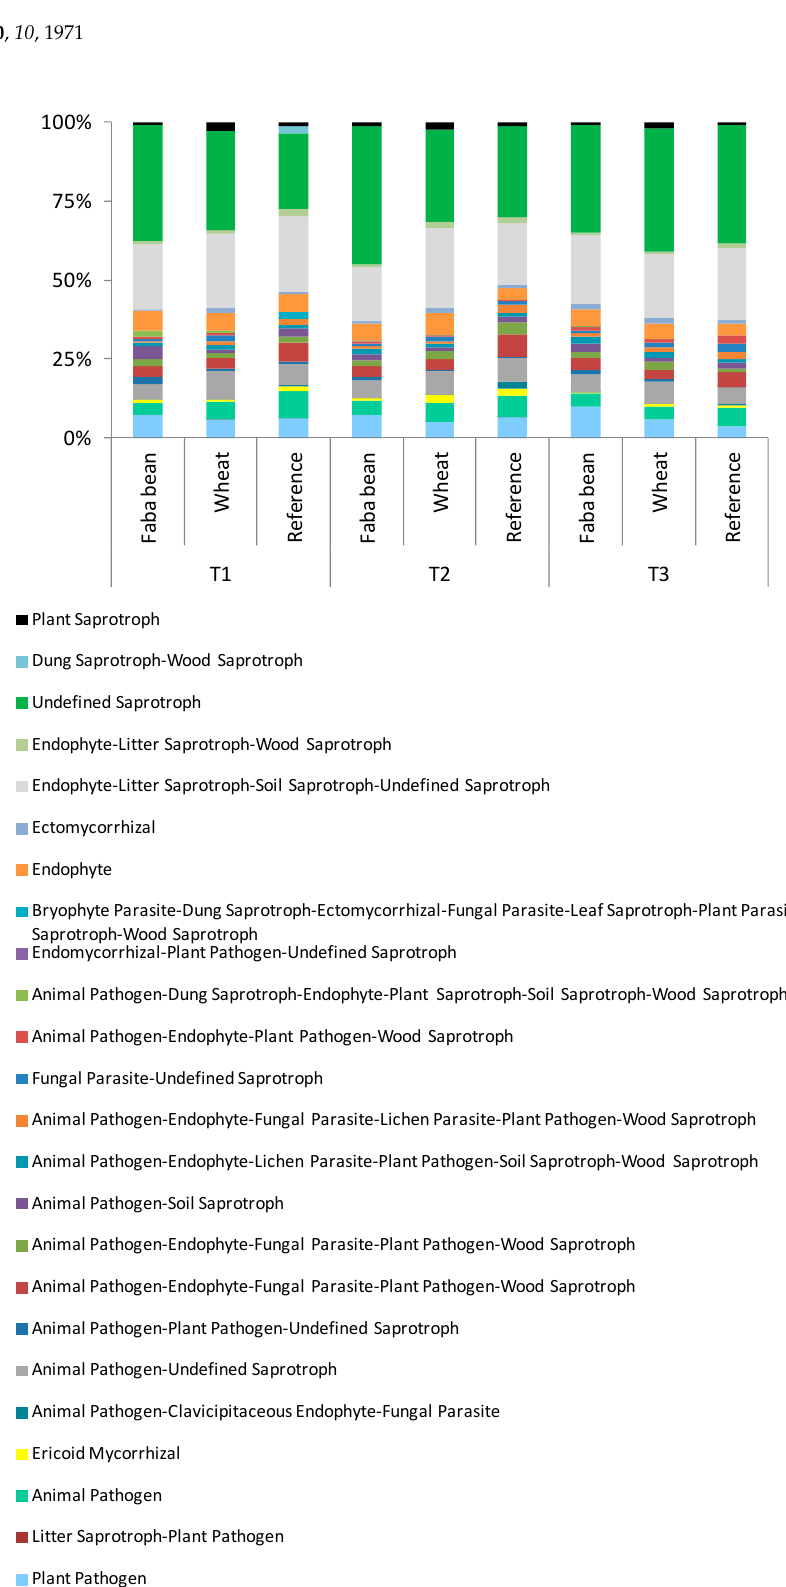
Figure 4. Fungal OTUs grouped in terms of guilds as affected by forecrop. OTUs with relative abundance greater than 1% were analyzed. T1, T2, and T3 denote: two months after residue incorporation into the soil, stem elongation, and the senescence stage of the subsequent wheat crop, respectively.